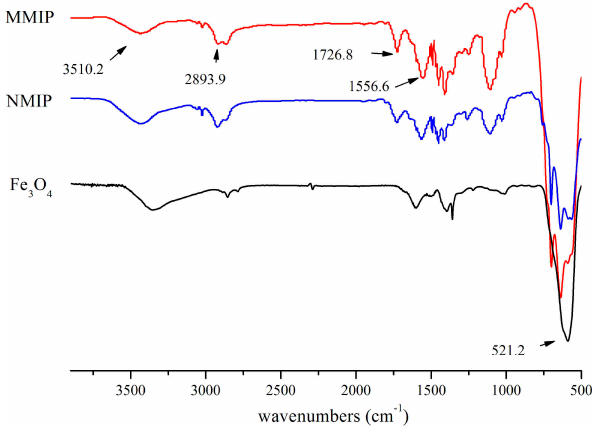
Figure 4. FT-IR spectra of the MMIP, NMIP and Fe 3 O 4 .